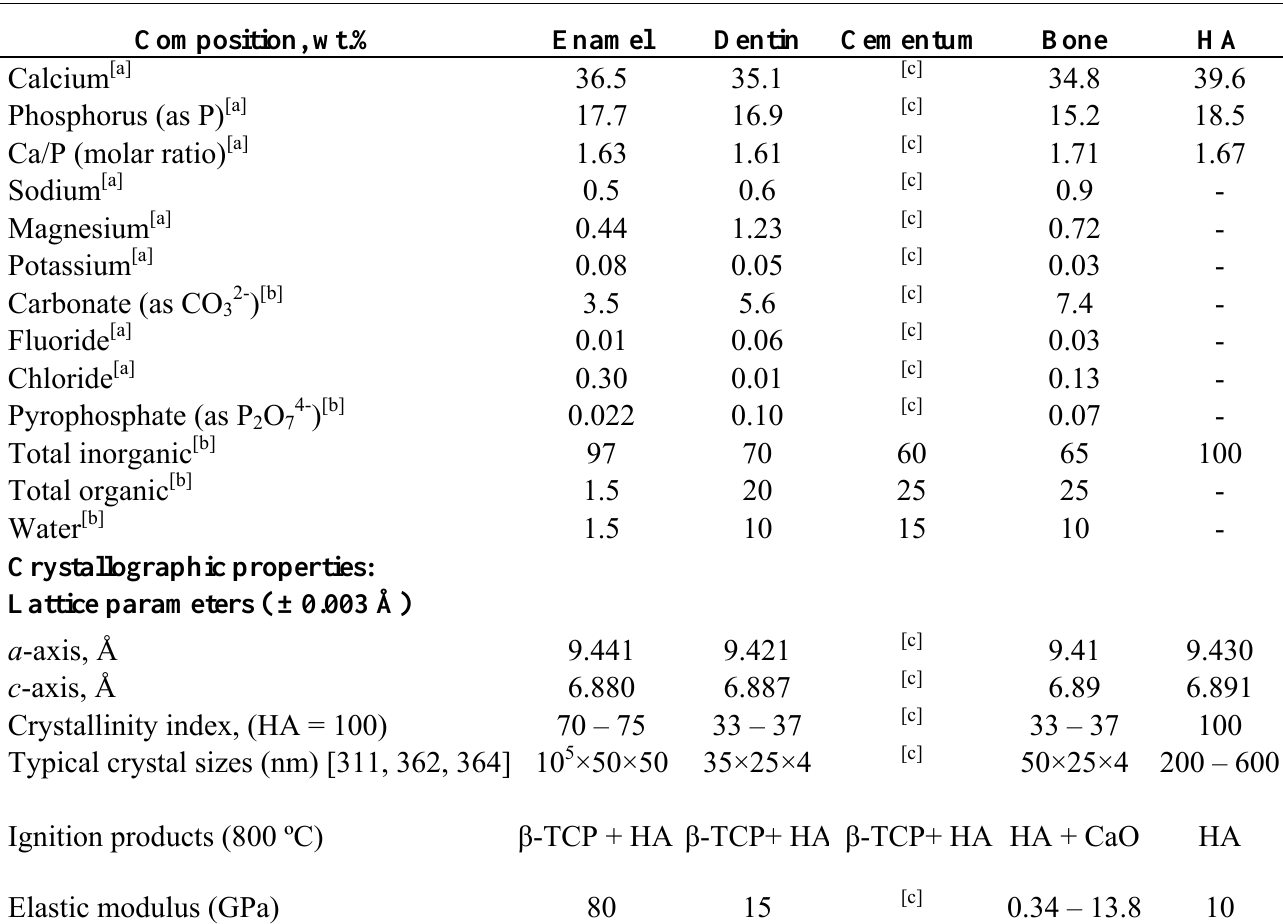
Table 1. Comparative composition and structural parameters of inorganic phases of adult human calcified tissues. Due to the considerable variation found in biological samples, typical values are given in these cases